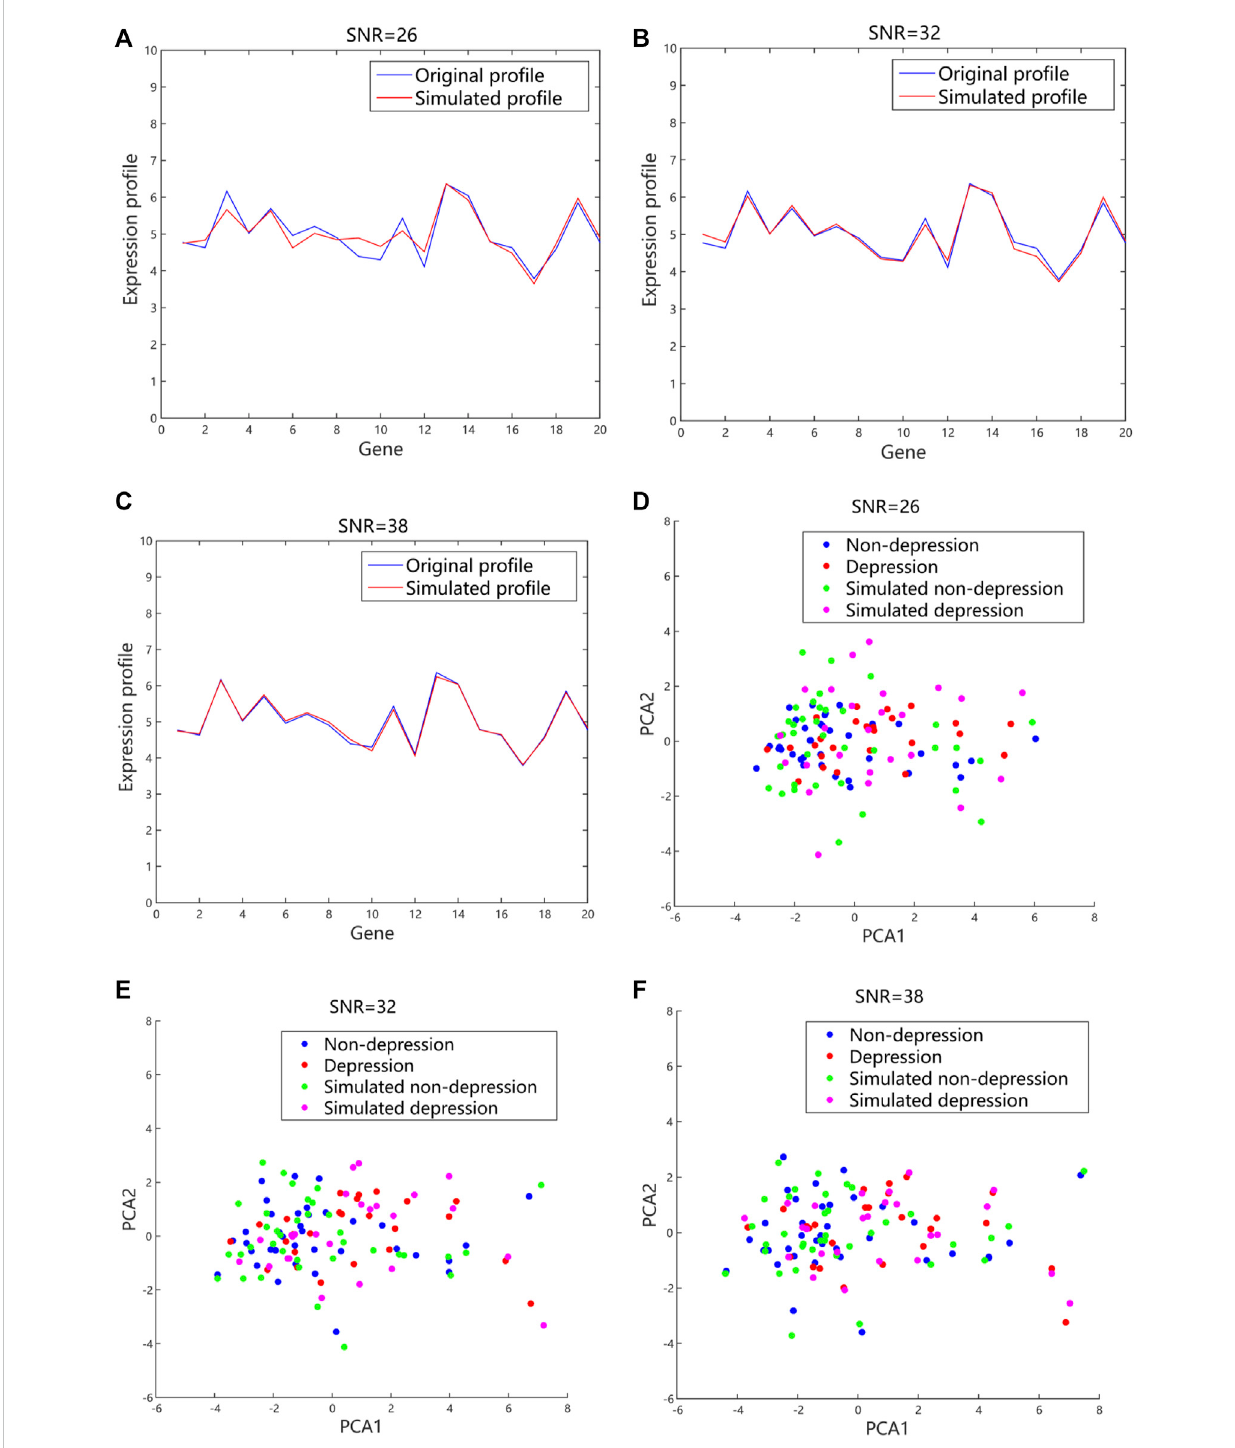
FIGURE 6 Thegeneratedgeneexpressiondataanddistributionsin2DPCAspacewithdifferentvaluesofSNRbasedontheadditivemodel. (A) , (B) ,and (C) The representativesimulatedexpressionpro fi leswithSNRvaluesof26,32and38,respectively.Thebluelinesreferredtotheoriginalexpressionpro fi lesfrom microarraydatasets.Theredlineswerethesimulatedexpressionpro fi les. (D) , (E) ,and (F) TherepresentativedistributionswithSNRvaluesof26,32and38, respectively. The blue and red dots represented the original data from microarray datasets. The green and purple dots were the simulated data. 2D, 2-dimension; PCA, principal component analysis; SNR,